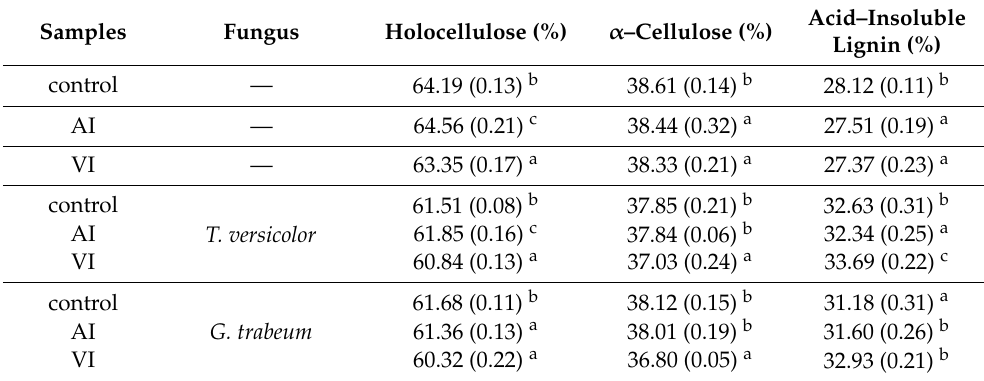
Table 1. Chemical compositions of untreated (control) and CuAz-treated (AI and VI) WFMRCs before and after 12 weeks of incubation with T. versicolor and G. trabeum fungi.